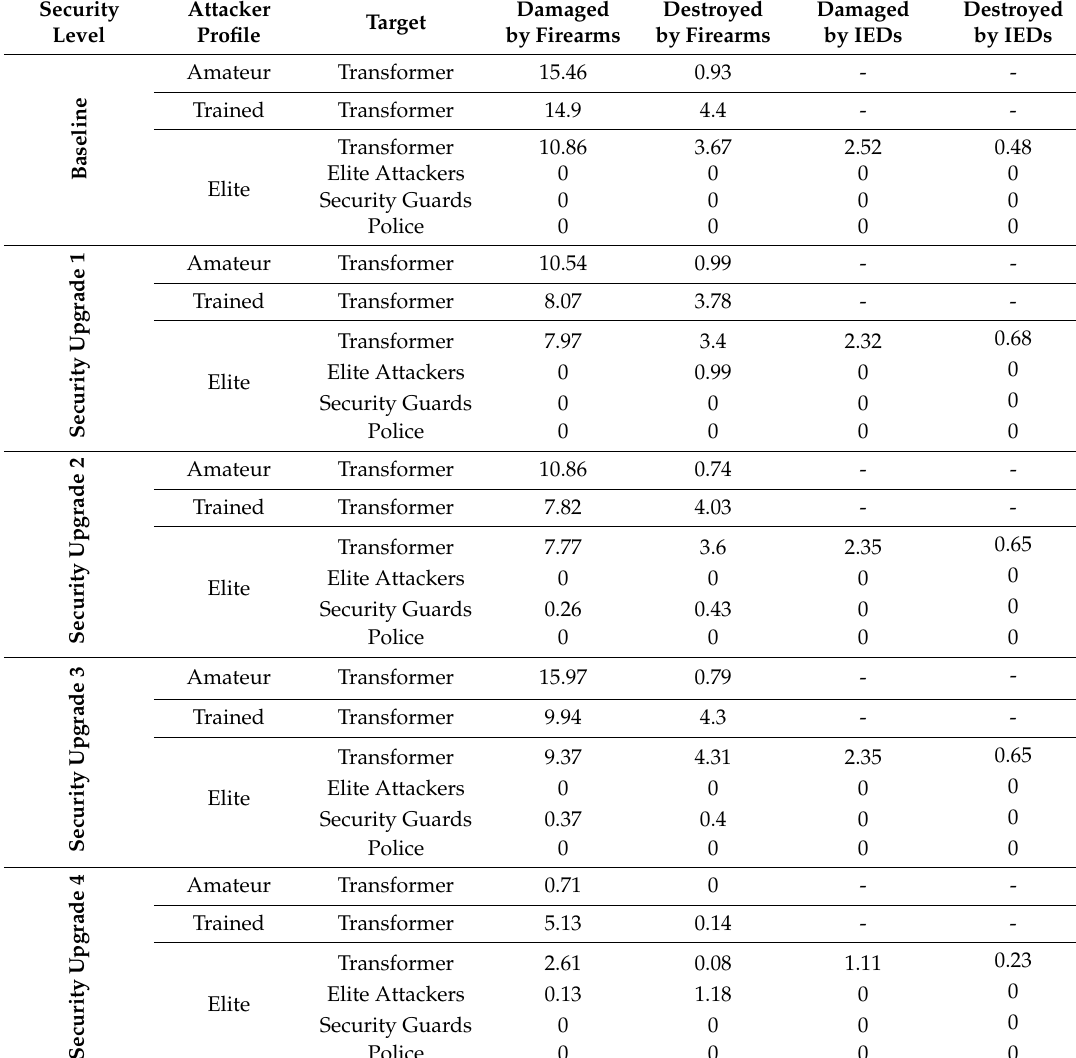
Table 4. Physical Attack Scenario Results,